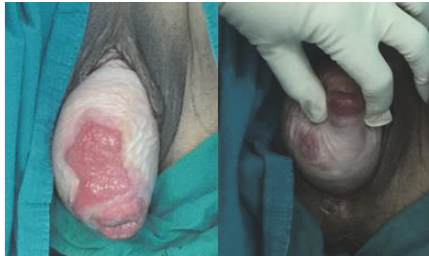
Figure 2: After treatment with broad-spectrum antibiotics, local estrogen therapy, analgesic and anti-inflammatory agents, and antiseptic dressing of the ulcerated area, the ulcer almost completely healed. The patient provided written informed consent for publica- tion of these photographs.